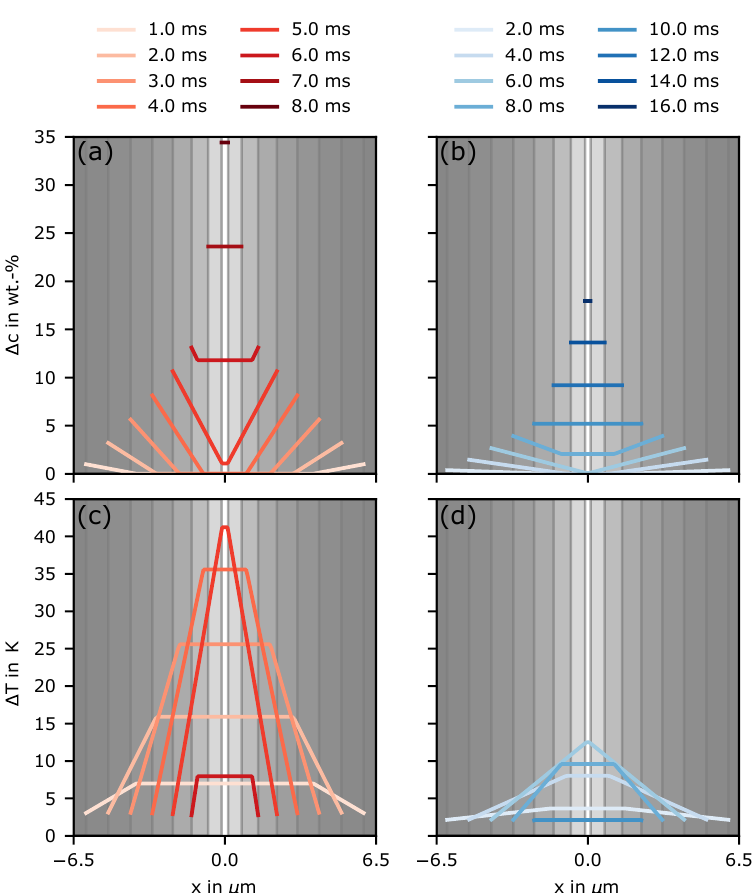
Figure 8. Concentration variation ∆ c = c l − c 0 in the interdentritic space over several times in the first melt line ( a ) and after a distance of 2mm during hatching ( b ). ( c , d ) The corresponding undercooling ∆ T evolution based on the local concentration/liquidus temperature and the local temperature evolution at the deepest melted points marked in Figure